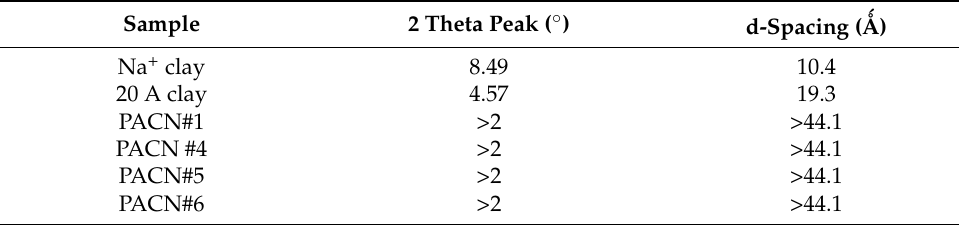
Figure 12. XRD patterns of PACN synthesized at varying oxidant concentrations. Table 3. Summary of XRD data for Na + clay, 20 A clay, and